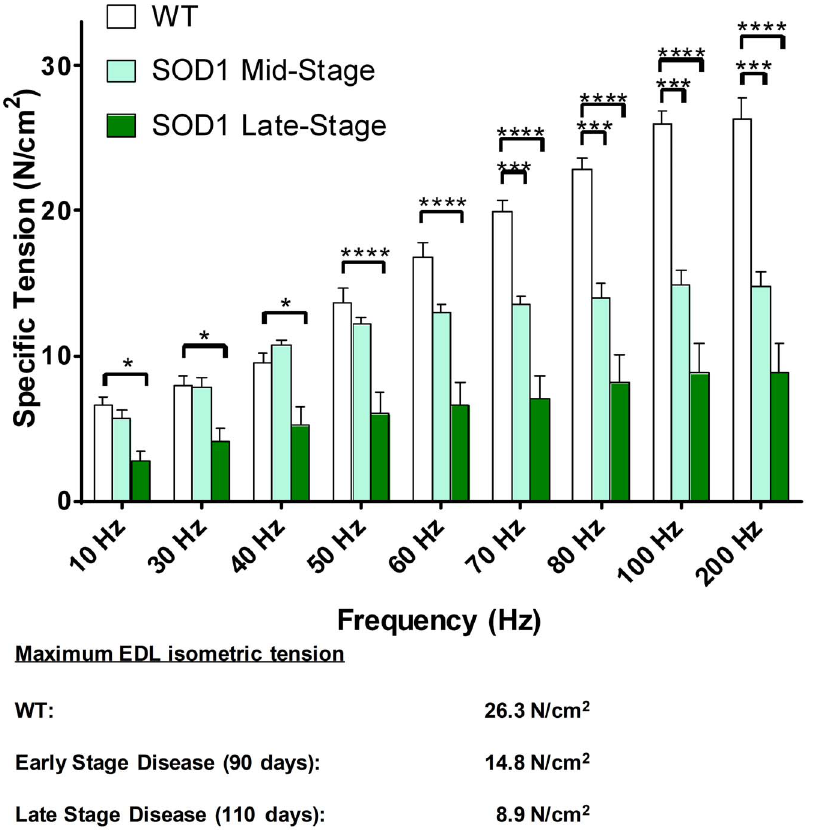
Figure 5. Isometric insitu force is reduced with age in B6SJL-SOD1 G93A mice. In situ assessment of EDL isometric force-frequency relationship in WT and B6SJL-SOD1 G93A transgenic mice at two stages of progressive neuromuscular disease. EDL muscle tension was assessed at mid-stage of disease (age=90–100 days) when signs of physical weakness were just apparent and late-stage disease (110–115 days) when frank limb paralysis was becoming evident using an in situ preparation of the extensor digitorum longus (EDL) muscle. (B6SJL mice, n=8; mid-stage B6SJL- SOD1 G93A mice, n=5; late-stage B6SJL-SOD1 G93A mice, n=6; Data are expressed as mean specific tension 6 SEM. *p , 0.05, ***p , 0.001, ****p , 0.0001 vs. WT).